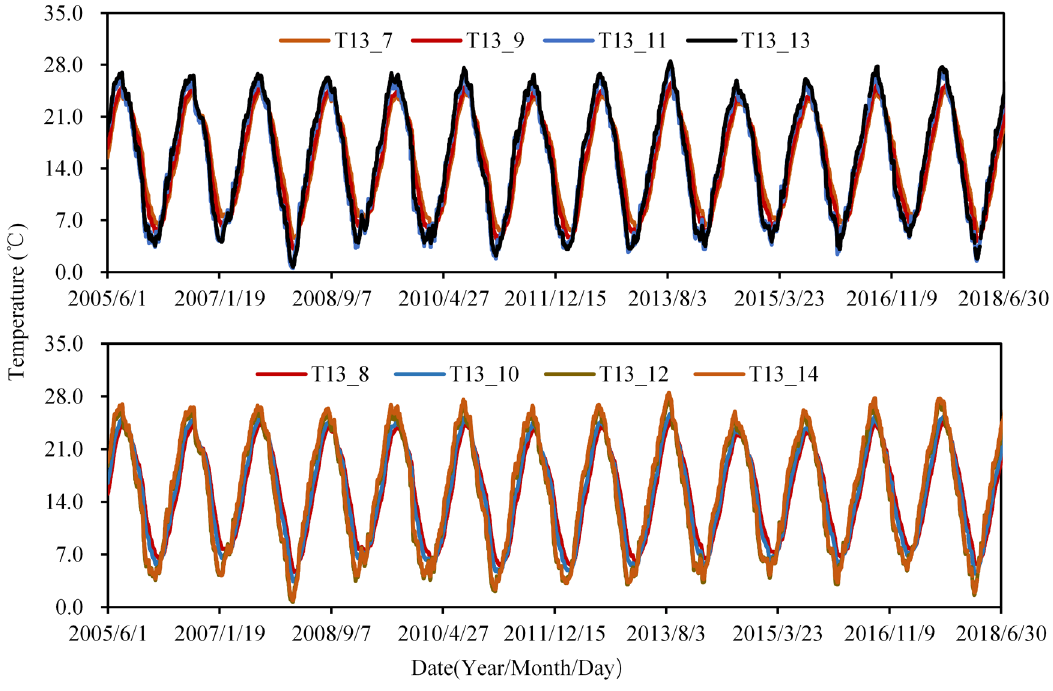
Figure 9. Air temperature and concrete temperature at selected typical measured points.